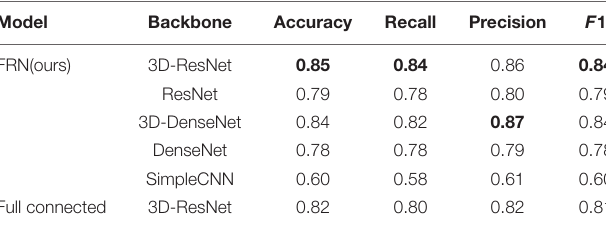
TABLE 2 | Results comparison with different network